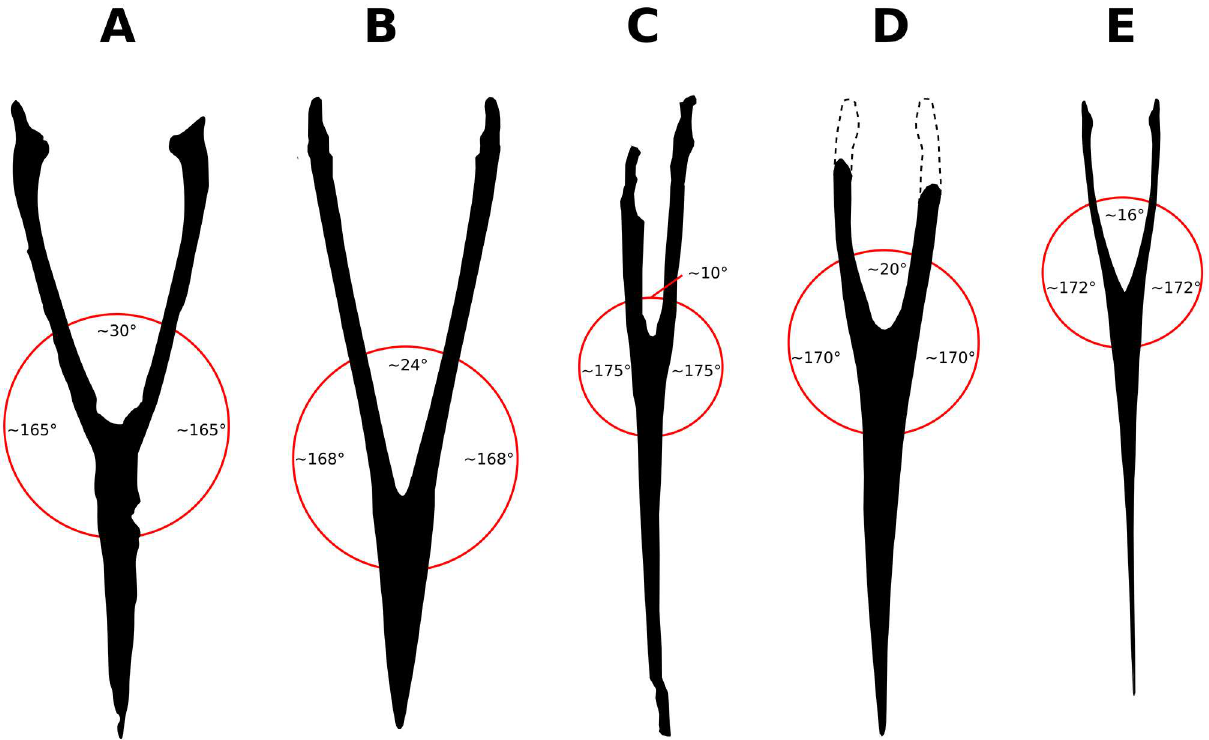
Fig 5. Selectedpterosaur mandibles in dorsal view. (A) Aymberedactyluscearensis gen. et sp. nov. (MN 7596-V).(B) Tapejara wellnhoferi (AMNH24440,based on [9]).(C) Quetzalcoatlus sp. (TMM42161–2,based on [42]).(D) Jidapterusedentus (holotype,based on [47]).(E) Pteranodon longiceps